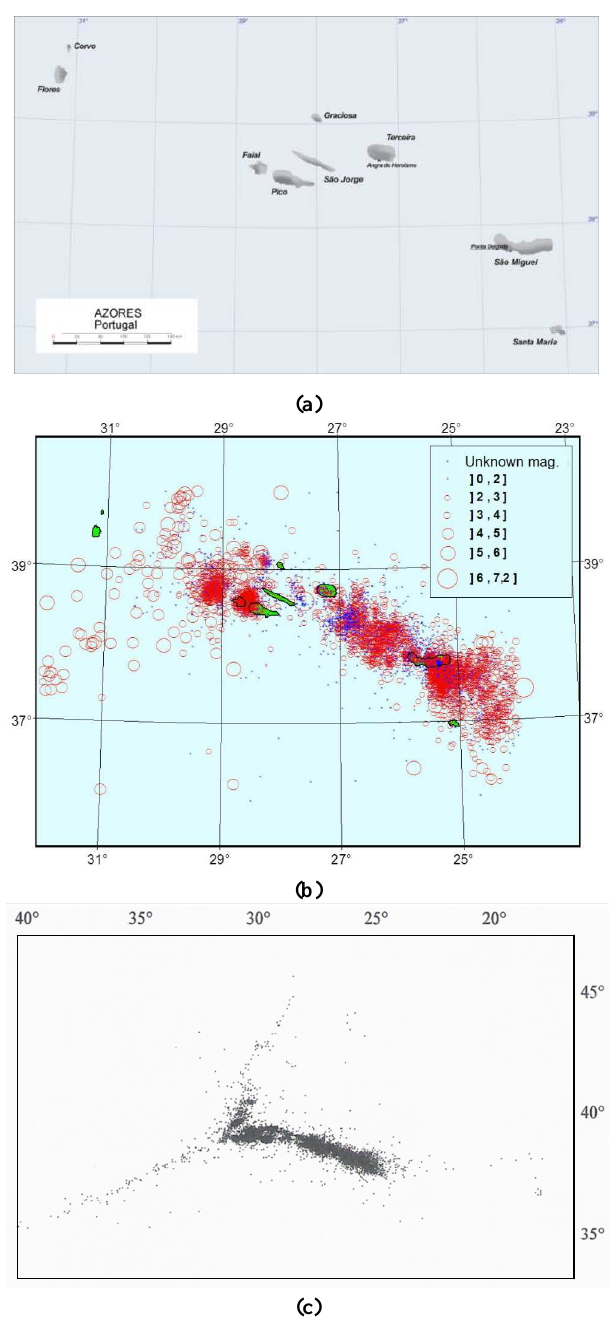
Figure 1a) The Azores Archipelago; b) epicentral map for 1915-2011; c) zoom of epicenters 4 Fig. 1. (a) The Azores Archipelago, (b) epicentral map for 1915– for the islands. 5 2011 and (c) zoom of epicenters for the islands.